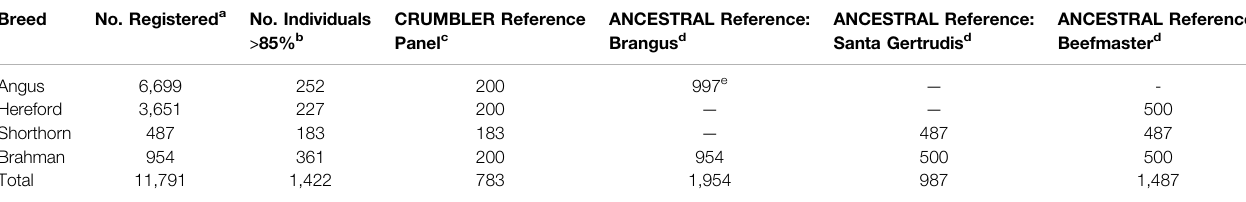
TABLE 2 | Genotype data for registered individuals from 4 breeds used to generate reference panels.